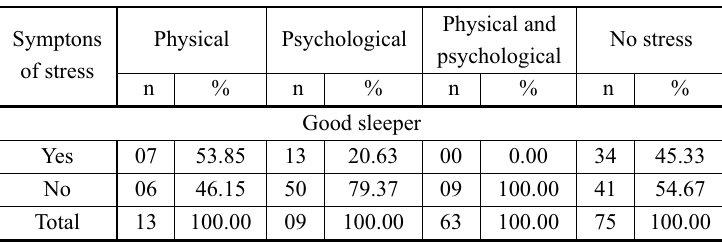
Absolute and relative frequency (%) of stress symptoms based on the assertion of sleeping well or not.